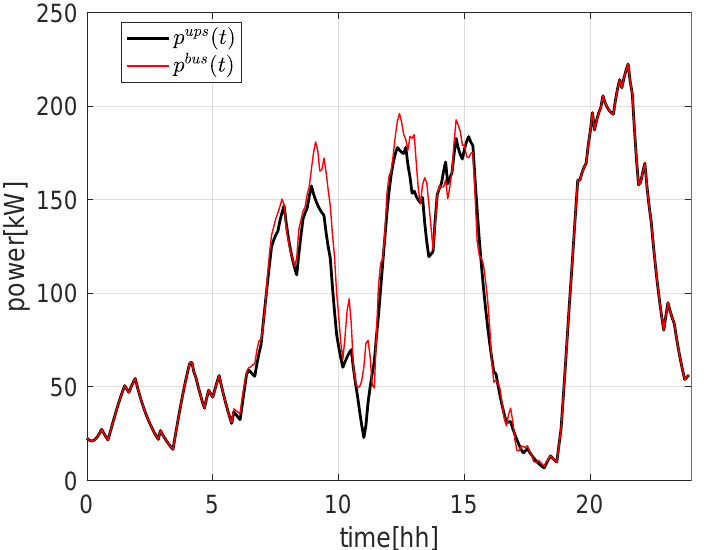
Figure 10. Evolution of power at POC in case of uncertainties for BUS (red) and UPS (black) configurations.